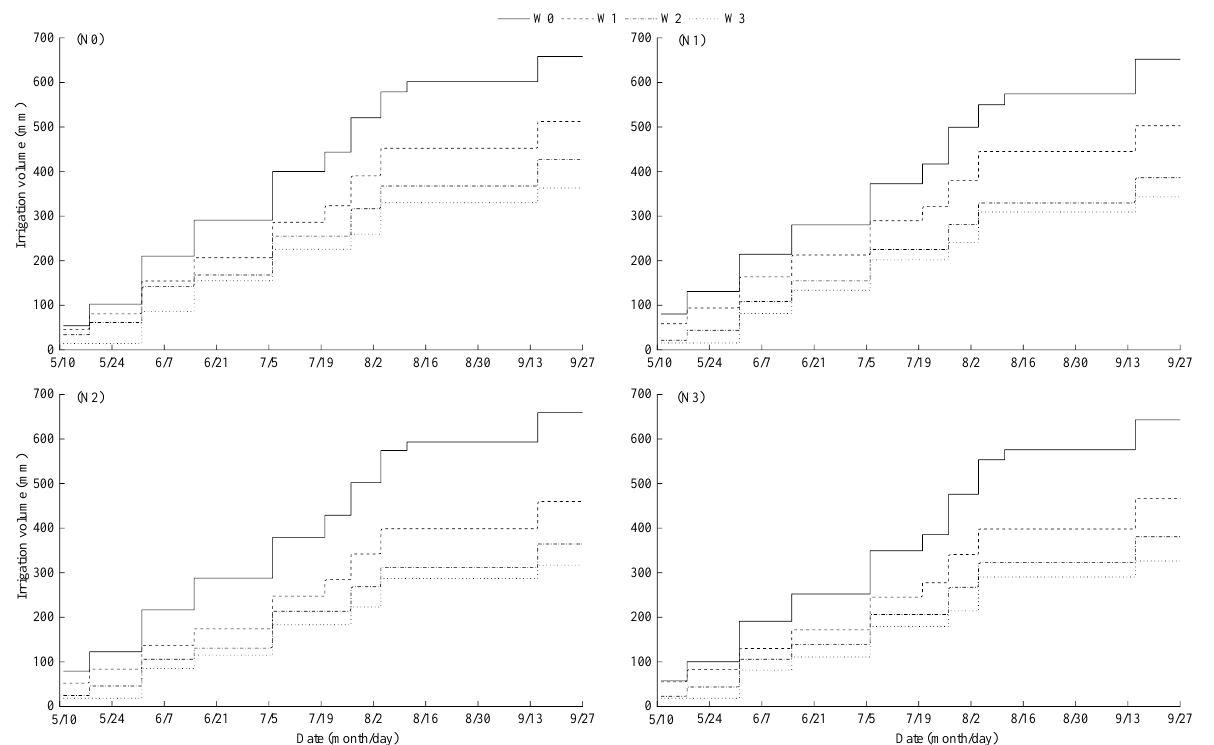
Figure 3. Irrigation process of each treatment during the growth period of bromus inermis. N0, N1, N2 and N3 refers to the nitrogen application level is 0 kg·ha −1 , 60 kg·ha −1 , 120 kg·ha −1 and 180 kg·ha −1 , respectively. 2.3. Indicators and Methods for Measurement.